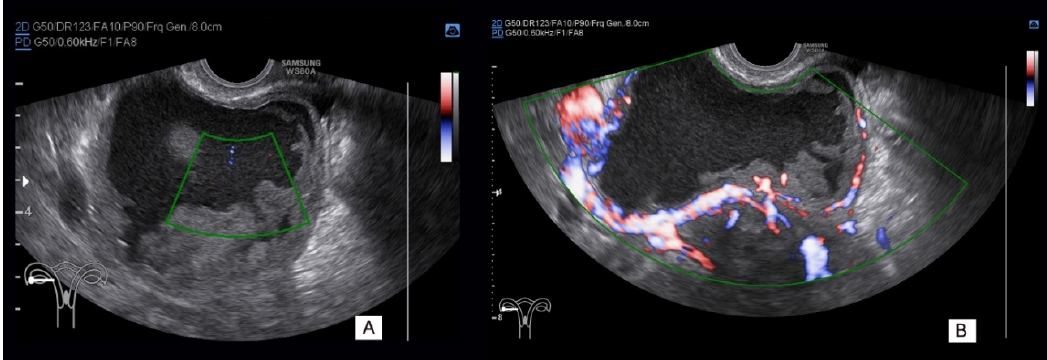
Figure 2. Grayscale and color Doppler findings in a 37-year-old woman with an adnexal solid–cystic unilocular tumor detected at ultrasound examination in the 17th week of gestation. Multiple internal solid parts and irregularly shaped multiple papillary projections are visible. No vascularity ( A , green borders window) and strong vascularization ( B , green borders window) were seen in different tumor solid parts on color Doppler imaging. Laparoscopy with a glove endobag was performed at 22 weeks of gestation, and decidualized endometrioma was confirmed on final histology.